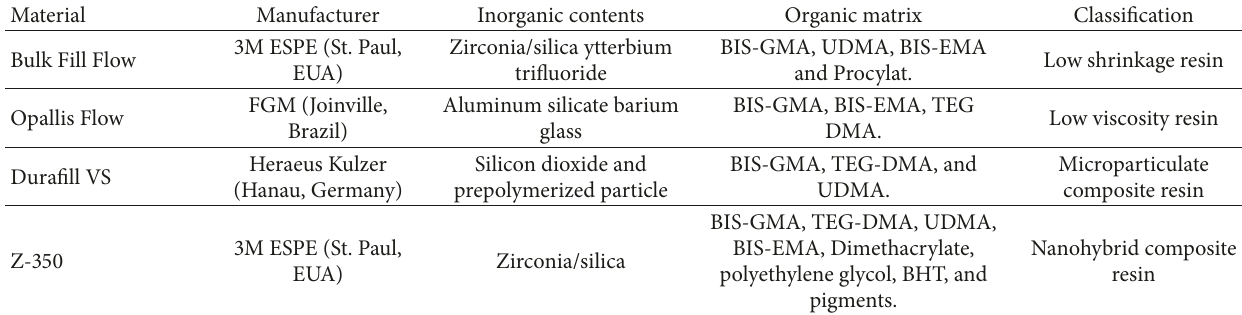
Table 1: Restorative materials used according to classification, manufacturers, and composition.